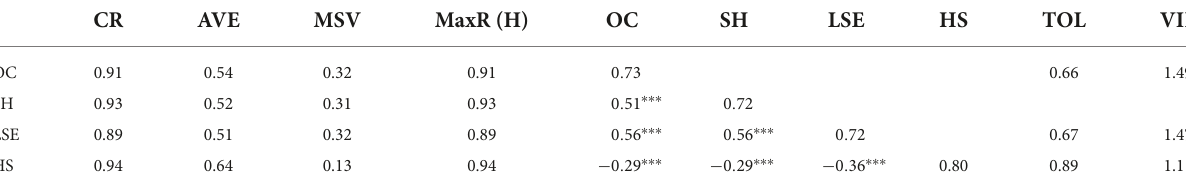
TABLE 2 Descriptive statistics, correlation, and discriminant